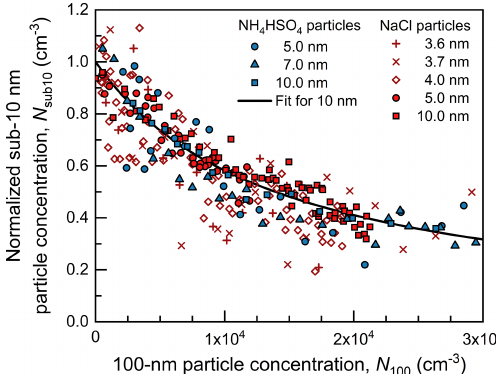
Figure 3. The normalized pseudo-steady-state concentration of monodisperse sub-10nm particles ( N sub10 ) as a function of 100nm particle concentration ( N 100 ). N sub10 is normalized by dividing it by the value measured at N 100 = 0. The curve is obtained by fitting Eq. (4) to the measured data.